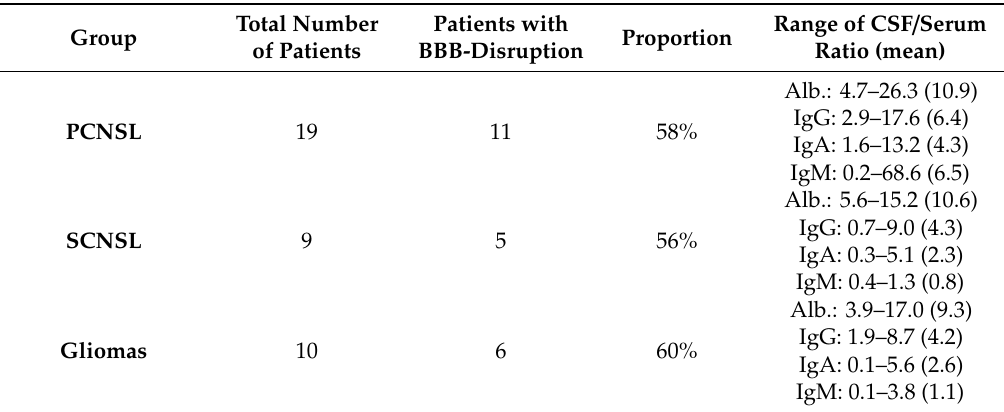
Table 2. Proportion of patients with a BBB disruption and corresponding CSF / serum concentration quotients of albumin, IgG, IgA and